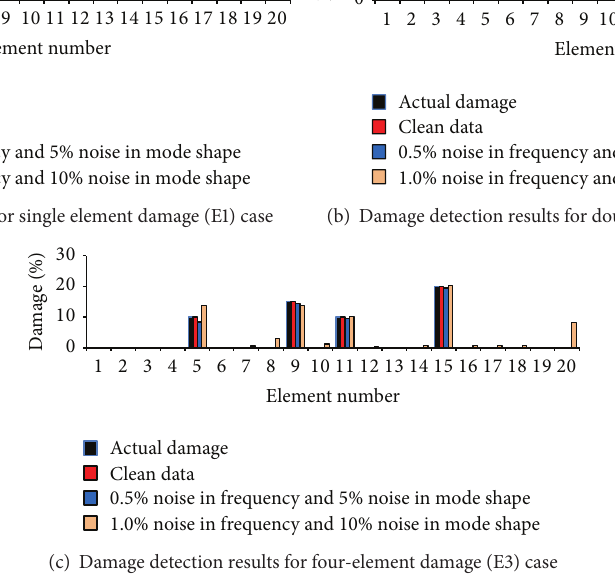
Figure 5: Results of damage detection in numerical cantilever beam.